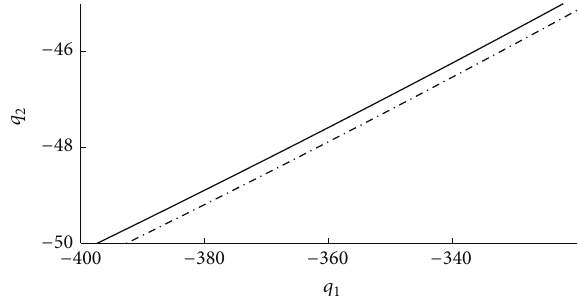
Figure 14: The dependencies for minimal control time from 𝛼 1 at different values of 𝛼 2 for 𝑝 󸀠 = 2 . Logarithmic scale used for ordinates.